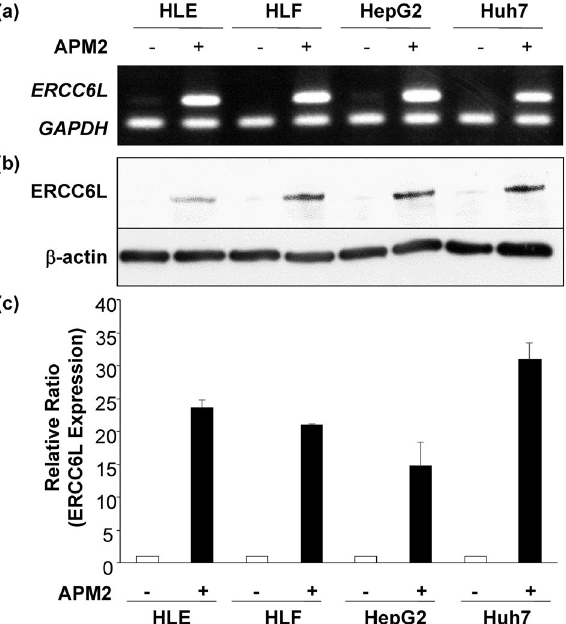
Figure 4. ERCC6L expression in the HCC cell lines with APM2 overexpression. ( a ) ERCC6L expression in the HCC cell lines assessed by RT-PCR. ( b ) ERCC6L expression in the HCC cell lines assessed by Western blotting. The images were grouped from the different gels and separated with the spaces. ( c ) A quantitative analysis of ERCC6L protein expression in the cell lines. Relative band ratio using the band intensities of β-actin as references. Results are expressed as mean, and error bars are expressed as standard deviations of three independent experiments. APM2, adipose most abundant